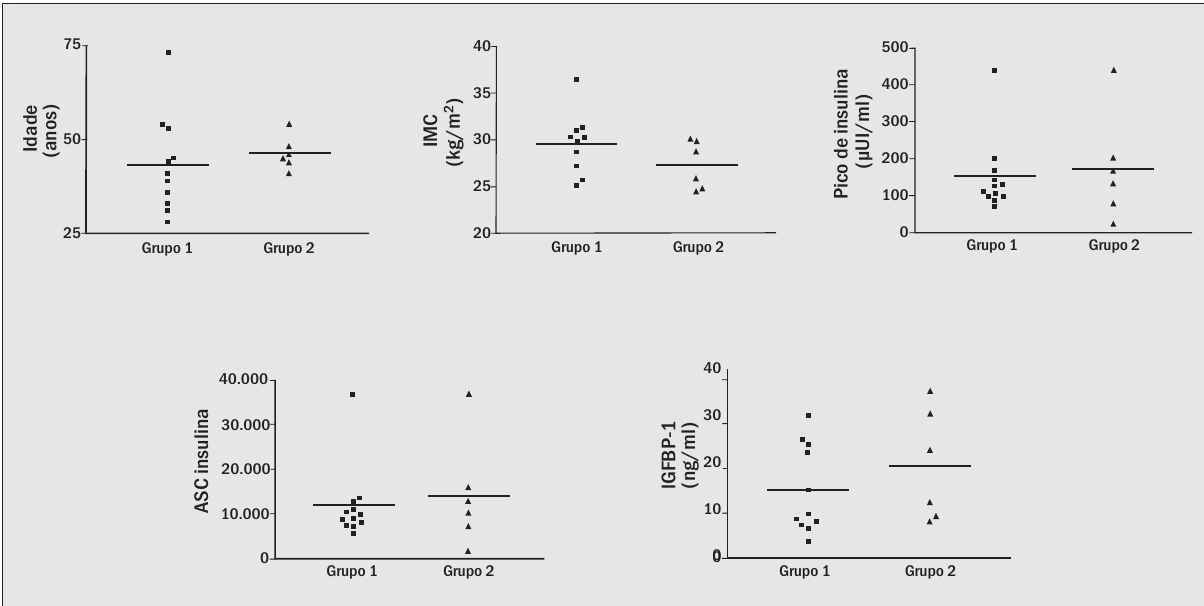
Figura 2 – Comparação entre idade (anos), IMC (kg/m 2 ), pico de insulina durante o oGTT ( (cid:181) UI/ml), área sob a curva de insulina durante o oGTT e concentrações séricas basais de IGFBP-1 (ng/ml) entre grupos de indivíduos intolerantes à glicose segundo critérios da OMS/NDDG (grupo 1, n = 11) e com glicemia de jejum alterada segundo critérios da ADA (grupo 2, n = 6) [ p = NS em todas as